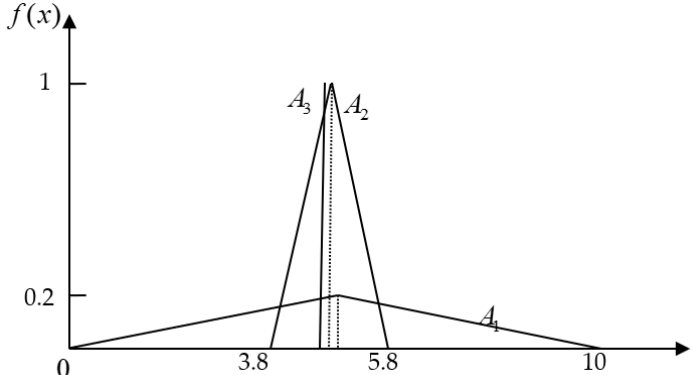
Figure 4. The probability density function in the second example.